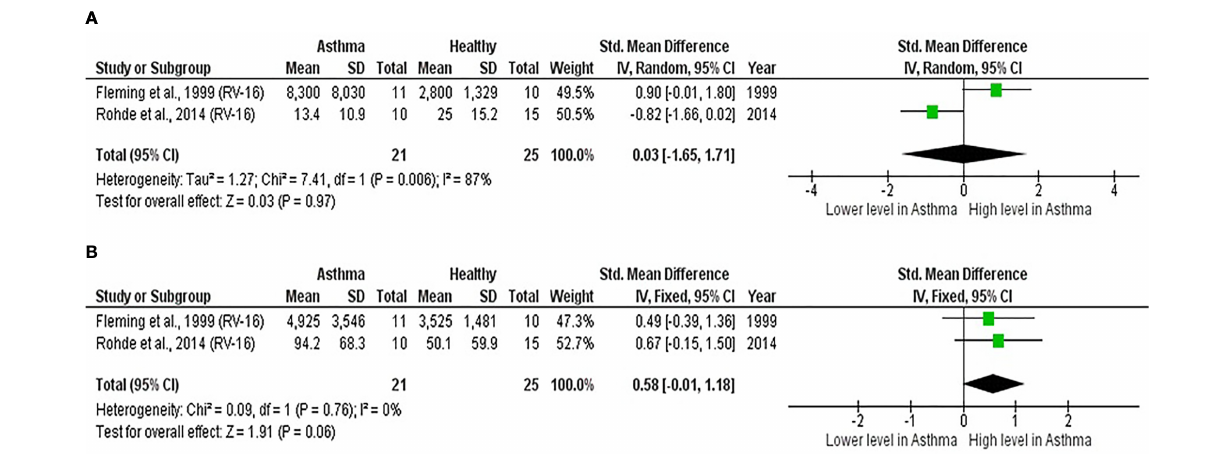
FIGURE 6 | Forest plot of (A) baseline and (B) post-infection IL-8 for adult atopic asthmatics vs non-atopic healthy adults experimentally infected with RV. (A) At baseline, there was no signi fi cant difference in bronchial IL-8 levels between atopic asthmatics and non-atopic healthy adults. (B) After experimental RV infection, atopic asthmatics had higher levels of bronchial IL-8 (ES: 0.58) compared to non-atopic healthy individuals, and it was close to reaching statistical signi fi cance ( p = 0.060).